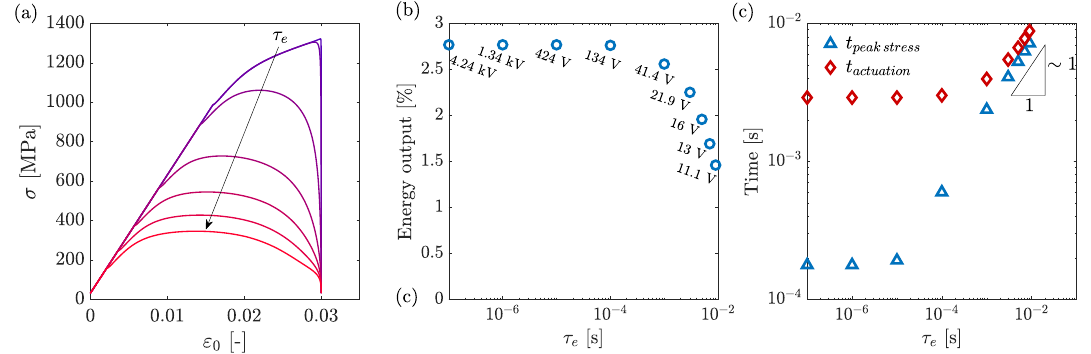
Figure 18. Actuation performance of a NiTi wire at different values of τ e . The simulated configuration corresponds to that presented in Figure 17. ( a ) Stress evolution as a function of strain. ( b ) Energy output of the actuation cycle for different values of τ e . The output energy was normalized relative to the energy fraction invested in the phase transformation, U in ( x = 1 ) . A corresponding actuation voltage for each value of τ e was calculated based on Equations (9) and (10). ( c ) Actuation duration, t actuation , and response time, t peakstress , for different values of τ e